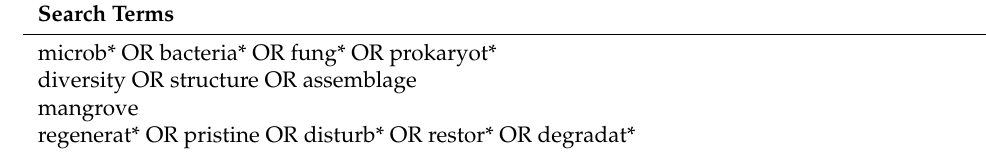
Table 1. Searched terms used for database